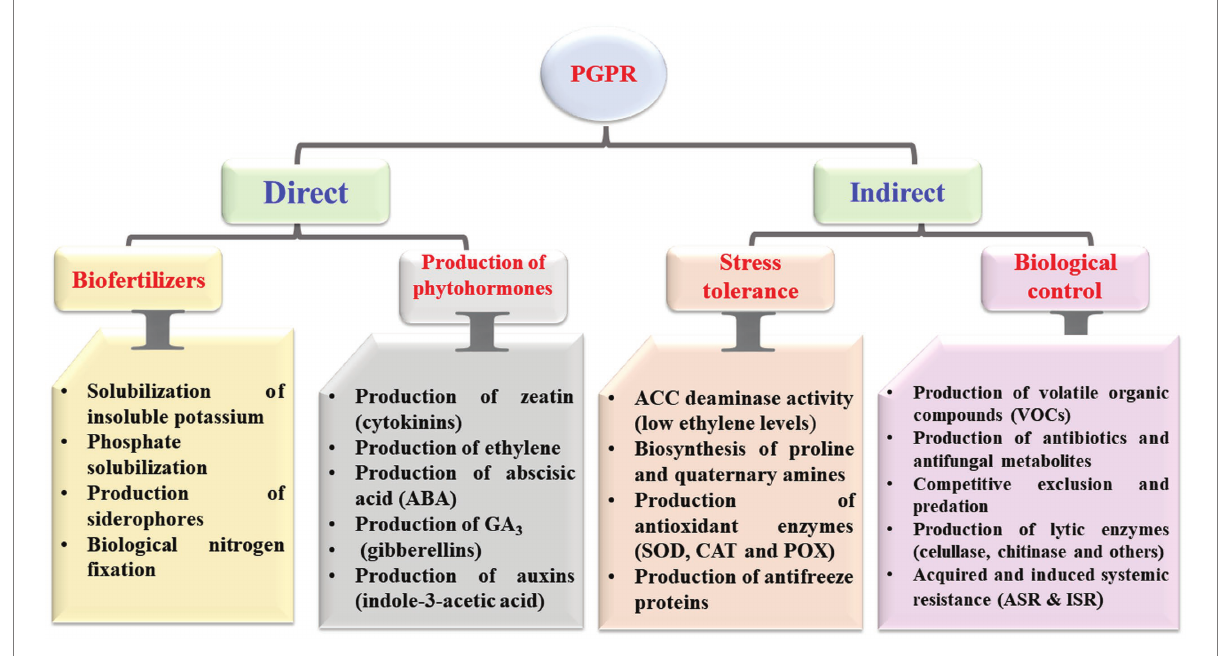
FIGURE 1 Direct and indirect mechanisms mediated by plant growth-promoting rhizobacteria (PGPR) with beneficial effects on host plants. ACC, 1-aminocyclopropane-1-carboxylic acid; SOD, superoxide dismutase; CAT, catalase; and POX,